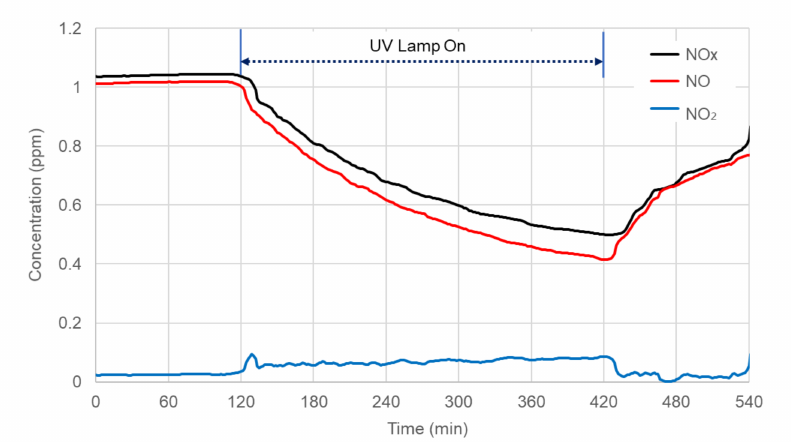
Figure 9. Variation of NO x concentrations during the experiment (UV intensity = 30 W/m 2 ).